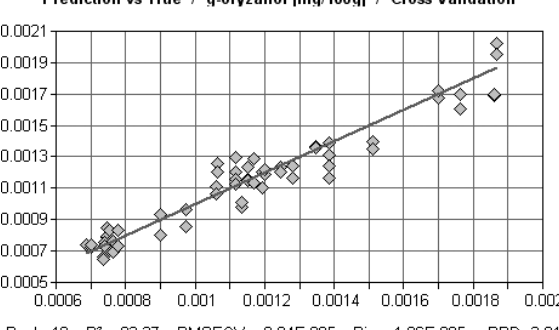
Fig. 1. Comparison of gamma oryzanol content of MGBR- various varieties between NIRS prediction and reference